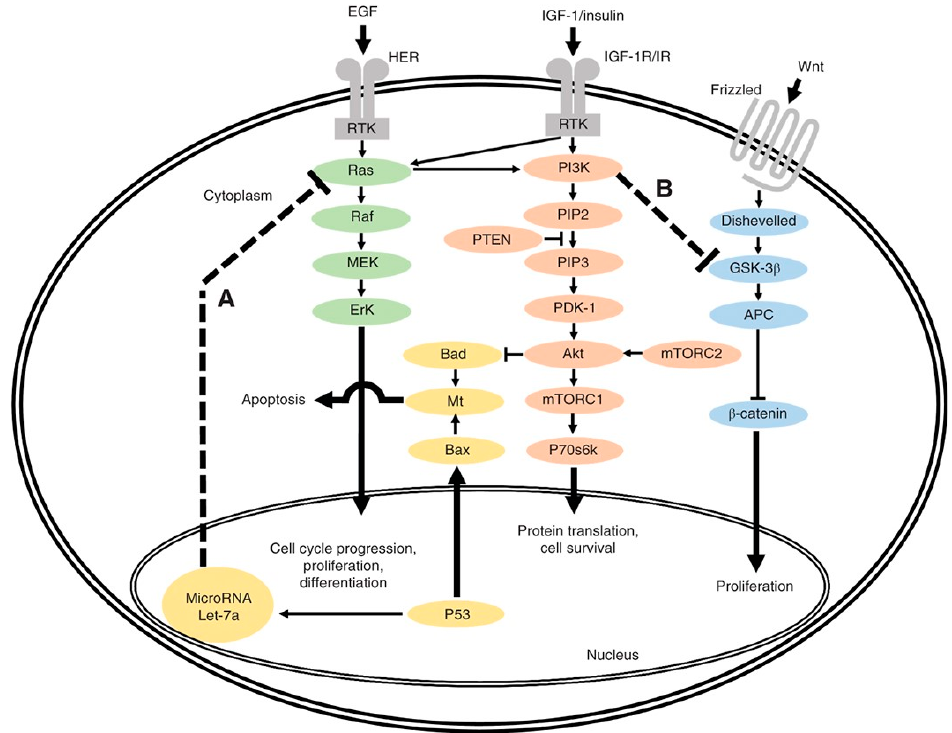
Figure 1. Overview of interlinked cellular signaling pathways involved in the proliferation and progression of colorectal cancer. In pathway A, TP53 normally inhibits activated RAS through lethal (Let) 7a23. However, Let-7a is not able to regulate activated RAS if TP53 is mutated. In pathway B, overactive phosphoinositide 3-kinase (PI3K), an oncogene, inhibits glycogen synthase kinase (GSK) 3 β 24, leading to β -catenin accumulation. EGF, epidermal growth factor; HER, human epidermal growth factor receptor; RTK, receptor tyrosine kinase; MEK, mitogen-activated protein kinase; ErK, extracellular signal-regulated kinase; Mt, mitochondria; IGF-1, insulin-like growth factor 1; IGF-1R/IR, IGF-1 receptor/insulin receptor; PIP2, phosphatidylinositol 4,5-bisphosphate; PTEN, phosphatase and tensin homologue; PIP3, phosphatidylinositol (3,4,5)-trisphosphate; PDK-1, phosphoinositide-dependent protein kinase 1; mTORC1/2, mammalian target of rapamycin complex 1/2; P70s6k, P70s6 kinase; APC, adenomatous polyposis coli. Used with permission [34].